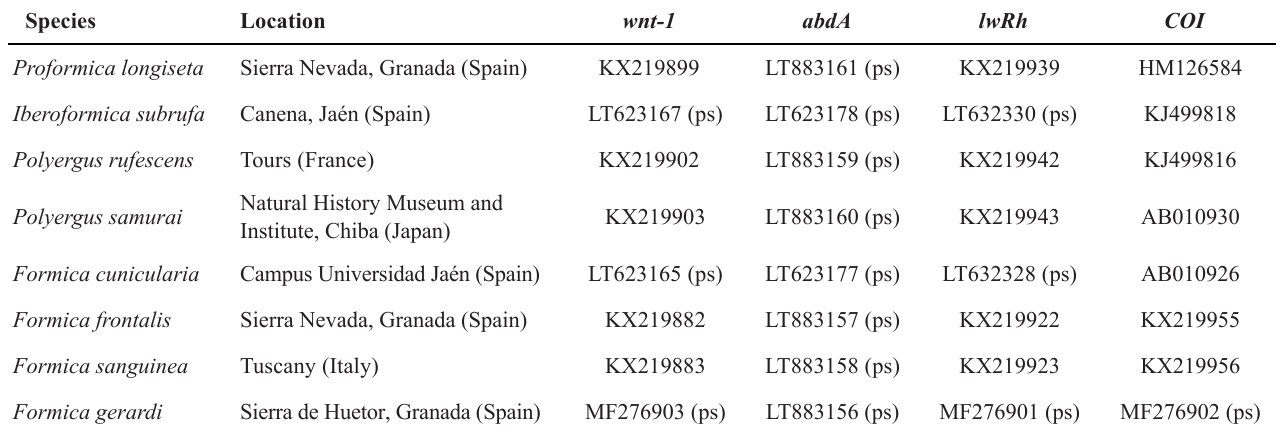
Table 1 . Sequences used for molecular analyses. For each species it is indicated the location of the sample and the GenBank accession numbers for the used genes. Some of the sequences were obtained for the present study (ps) and the remaining sequences were retrieved from the